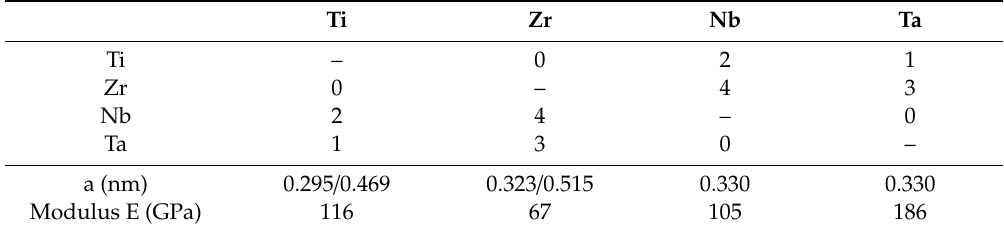
Table 1. Heat of mixing between constituent elements and the lattice constant, a, in their pure metal state, and their related physical